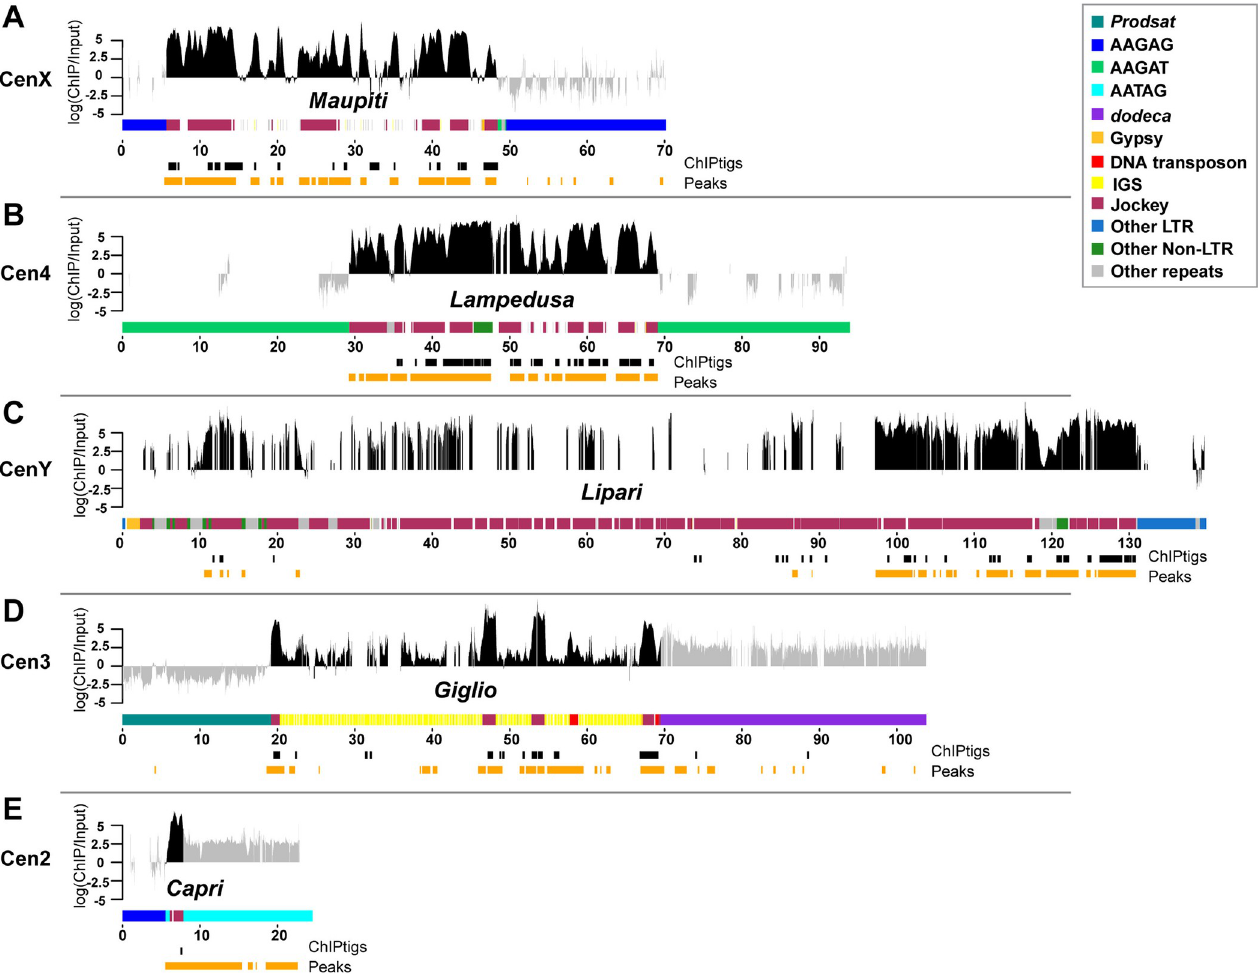
Fig 2. CENP-A occupies DNA sequences within putative centromere contigs. Organization of each CENP-A-enriched island corresponding to centromere candidates: (A) CenX, (B) Cen4; (C) CenY; (D) Cen3; (E) Cen2. Different repeat families are color coded (see legend; note that Jockey elements are shown in one color even though they are distinct elements). Shown are the normalized CENP-A enrichment over input (plotted on a log scale) from one replicate (replicate 2, other replicates are in S4 Fig) colored in gray for simple repeats and black for complex island sequences. Although the mapping quality scores are high in simple repeat regions, we do not use these data to make inferences about CENP-A distribution (see text for details). The coordinates of the significantly CENP-A-enriched ChIPtigs mapped to these contigs (black), and the predicted ChIP peaks (orange) are shown below each plot. See also S4 Fig and S3 and S4 Tables. Cen2, centromere 2; Cen3, centromere 3; Cen4, centromere 4; CENP-A, centromere protein A; CenX, X centromere; CenY, Y centromere; ChIP, chromatin immunoprecipitation; IGS, intergenic spacer of the ribosomal genes; LTR, long terminal repeat; Prodsat , Prod